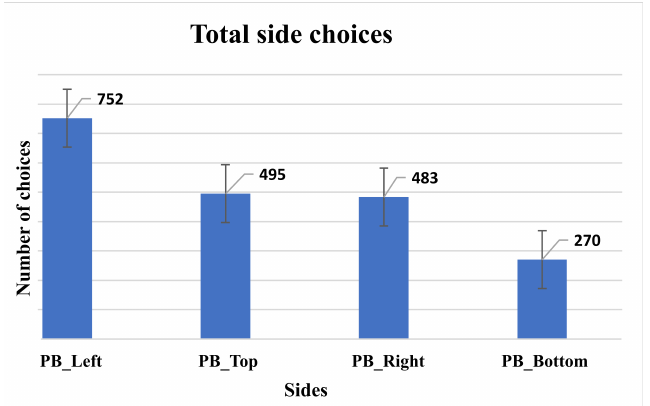
Figure 4. Preferences of users during the first stage of tests.